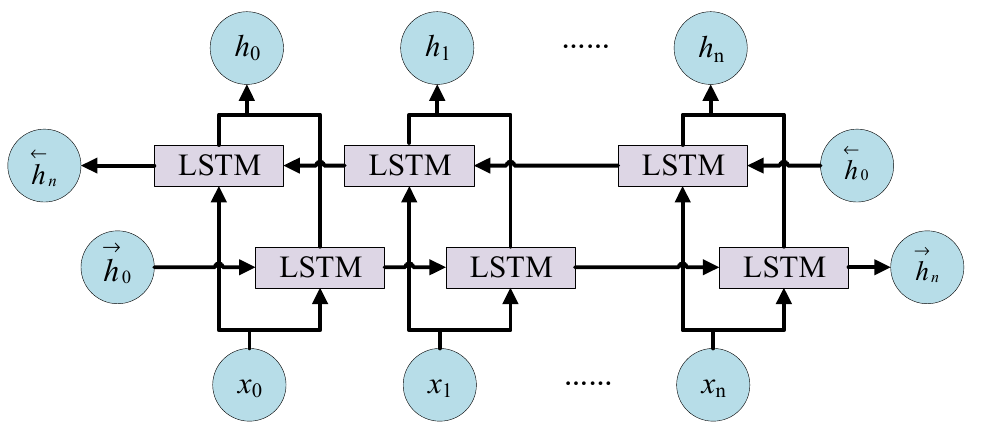
Figure 6. Bidirectional long short-term memory (BiLSTM) neural network structure. The BiLSTM network is composed of forward LSTM layer and reverse LSTM layer,